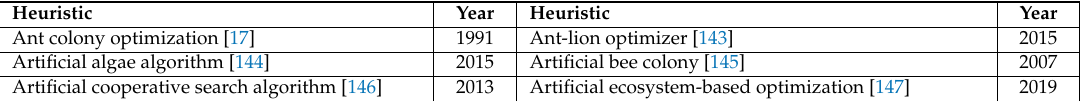
Table A1. Over one hundred heuristics used in the power and energy systems domain.